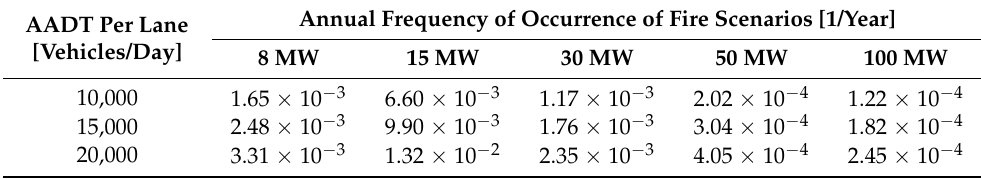
Table 2. Annual frequency of occurrence of fire scenarios simulated using FDS + Evac. AADT Per